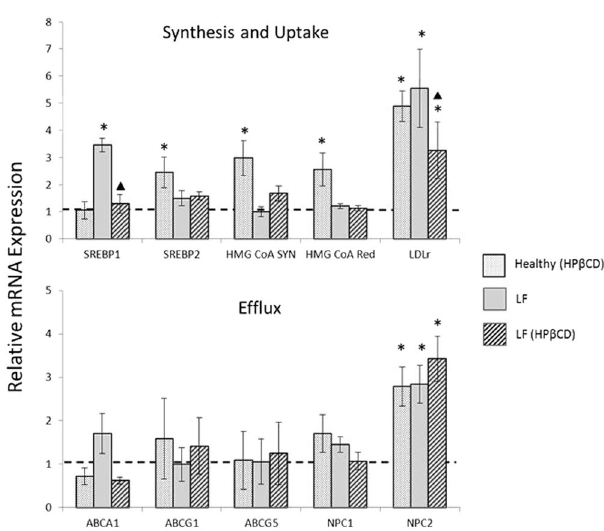
Figure 3. Response to HP β CD treatment varies according to initial cholesterol levels. mRNA levels for genes associated with cholesterol biosynthesis and uptake ( top graph ) and efflux ( bottom graph ). Asterisks ( * ) indicate statistical significance ( p < 0.05) relative to healthy untreated cells. ▲ Indicates statistical significance comparing LF-loaded HP β CD-treated cells relative to LF loaded cells. To be considered statistically significant the observed up or downregulation difference relative to control was ≥ 2.0 and the p-value <